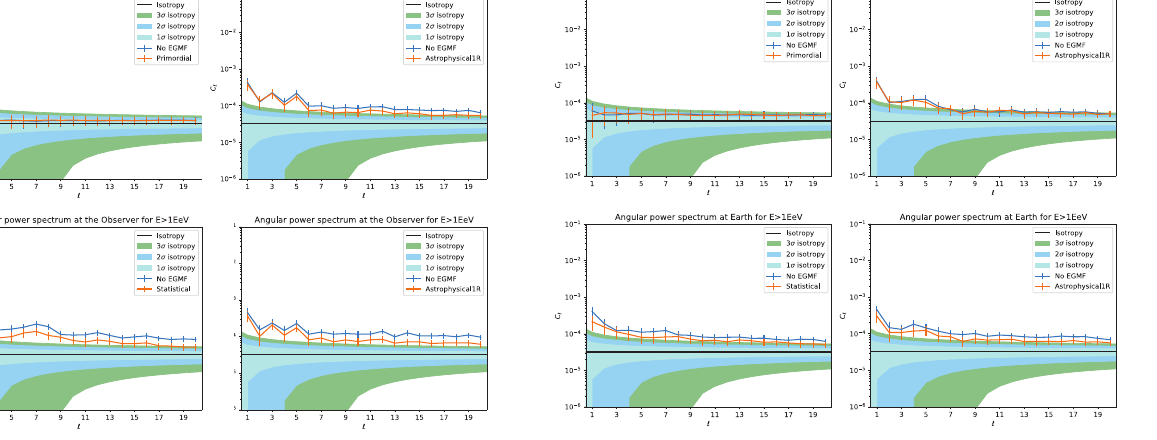
Figure 4. Same as Figure 3 after the galactic